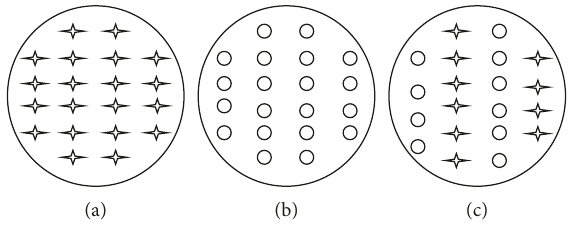
Figure 1: Pot experiment design drawing. (a) Monoculture of ryegrass; (b) Monoculture of alfalfa; (c) Intercropping of alfalfa and ryegrass. represents